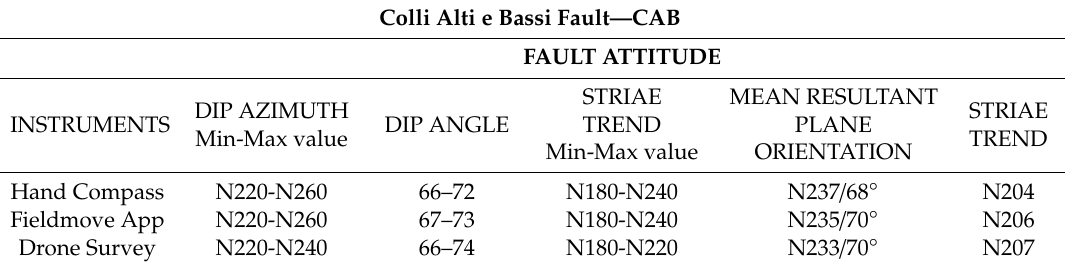
Table 1. Summary table of the data collected with the di ff erent instruments (Compass, Fieldmove, Aero-Photogrammetric